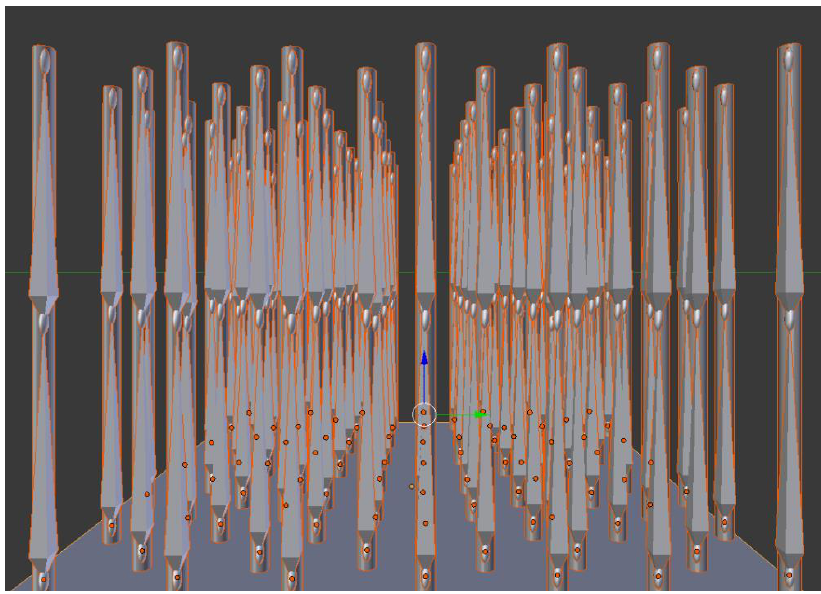
Figure 3. Hair surface showing two bones armature that supports the structure of the cylinder.